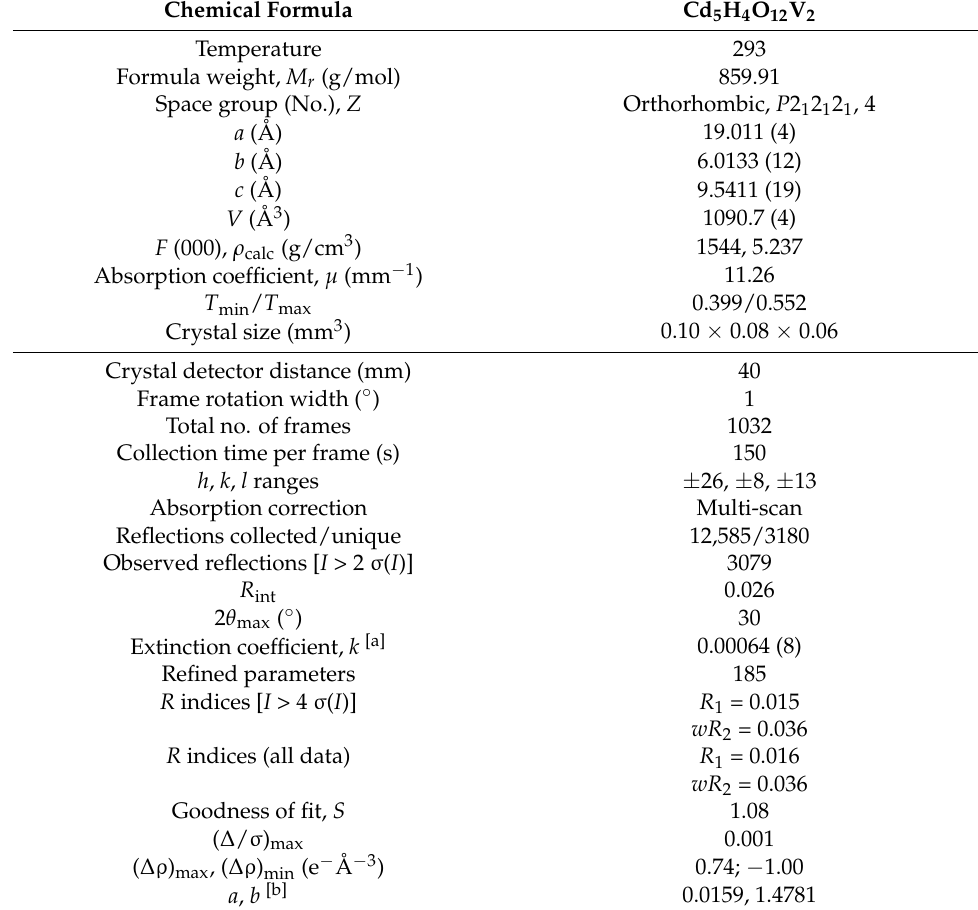
Table 1. Crystal data, data collection, and refinement details for Cd 5 (VO 4 ) 2 (OH) 4 . Chemical Formula